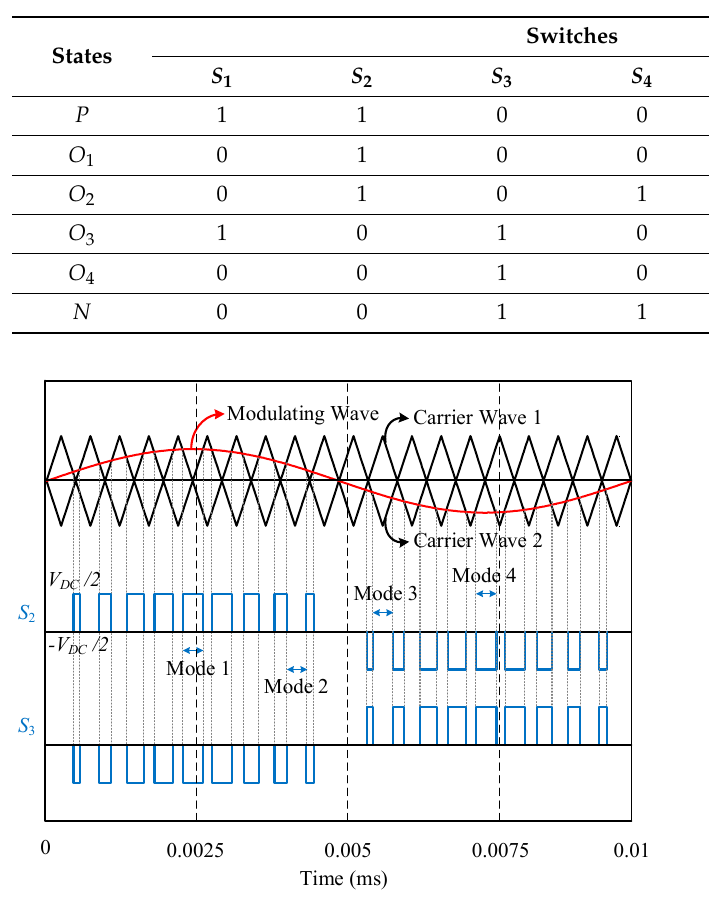
Figure 4. Switching pulses of the Ga 2 O 3 devices of the hybrid ANPC using LSPWM.